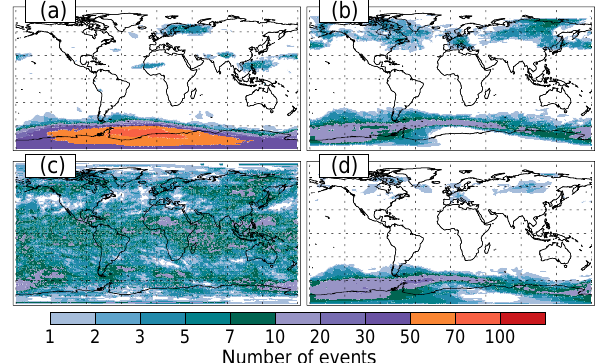
Figure 3. Geographical distribution of mini-hole events for OMI data in 2005. Four different mini-hole definitions are compared: (a) using a constant threshold of 220DU, (b) using as thresholds the monthly mean minus 70DU, (c) using as thresholds the monthly mean minus 2 times its standard deviation, and (d) the percentage threshold discussed in the text. Red/blue indicate relatively high/low number of events counts.